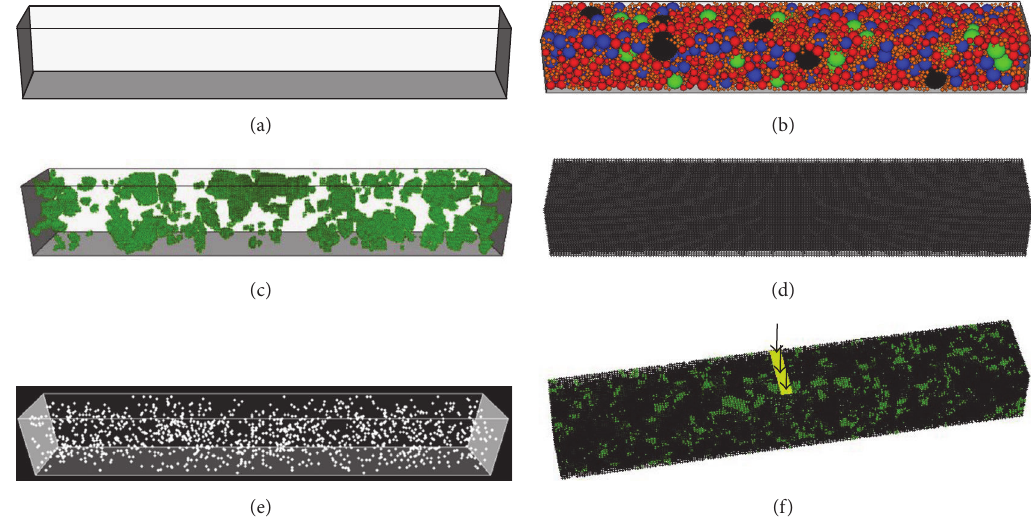
Figure 3: Illustration of modeling procedure: (a) generation of virtual sample space; (b) generation of graded spherical aggregates; (c) generation of irregular aggregates; (d) generation of asphalt mortar; (e) generation of air voids; (f)